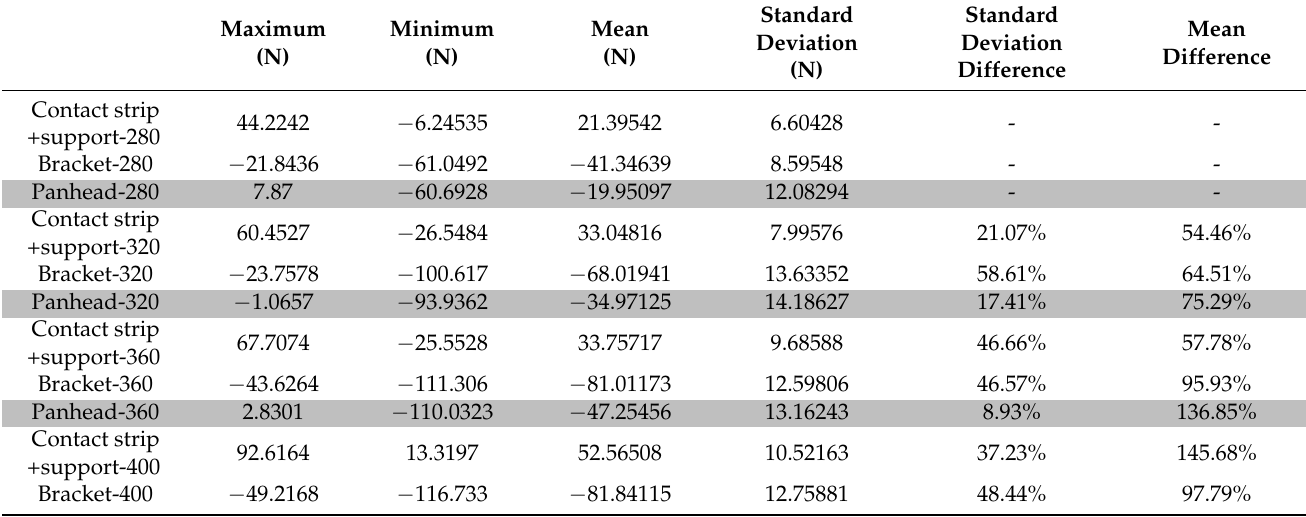
Table 2. Statistical results of panhead aerodynamic lift passing through tunnel at different